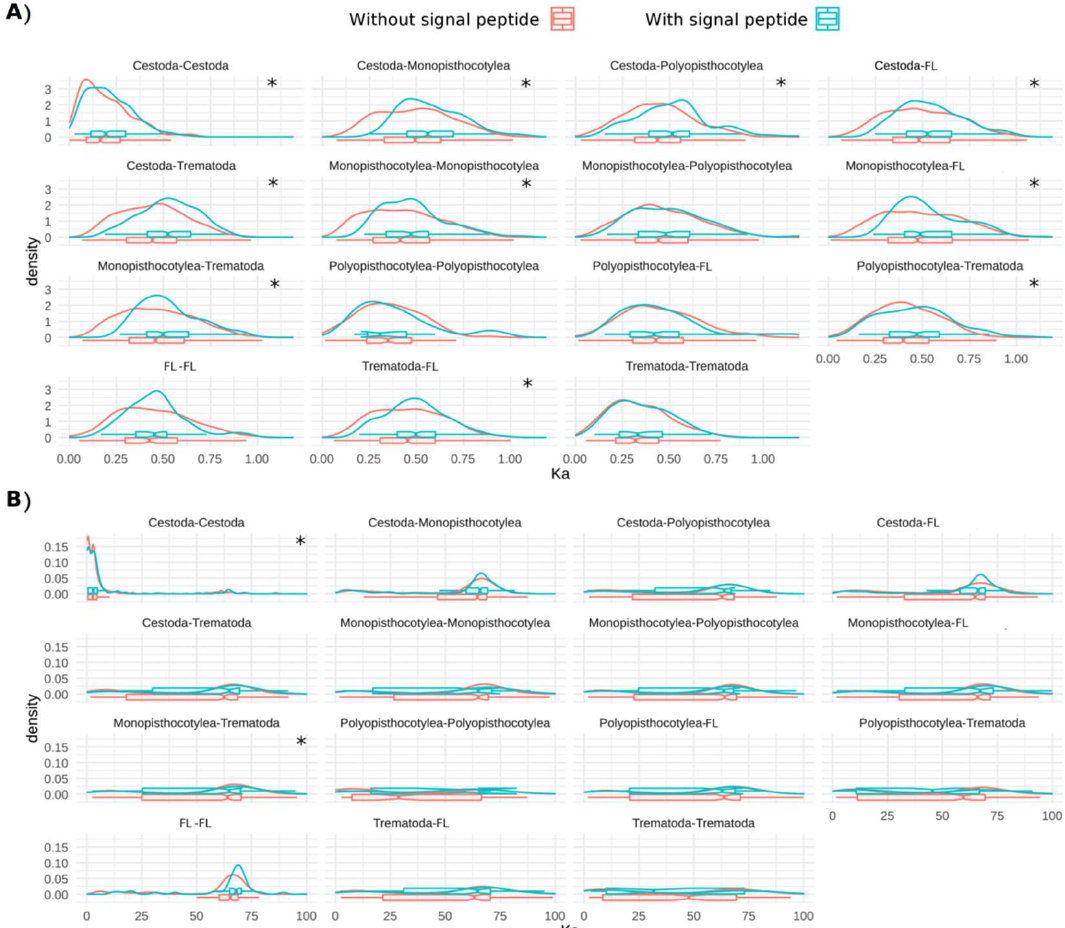
Figure 6. The distribution of ( A ) Ka and ( B ) Ks in single-copy OGs of peptidases and inhibitors of platyhelminths with/without predicted signal peptides. FL indicate the free-living platyhelminths Bothrioplana semperi and Schmidtea mediterranea . * indicates p < 0.05.